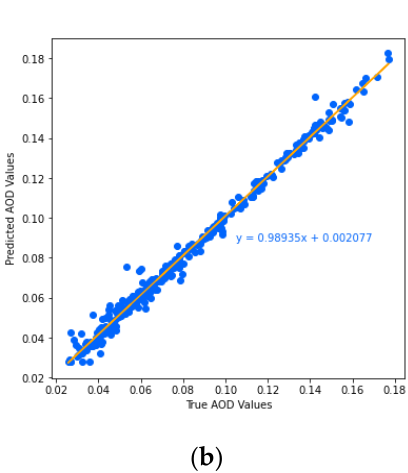
Figure 3. MAE for epoch ( a ) -BBE; ( b ) +BBE.